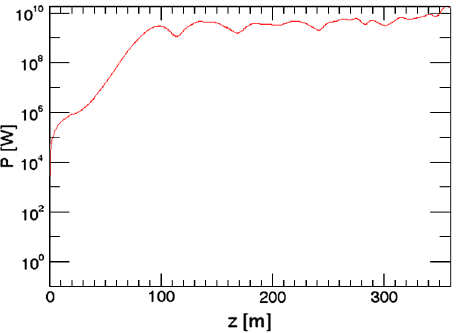
FIG. 11. Power growth and saturation in 1 A˚ x-ray FEL predicted by GENESIS .